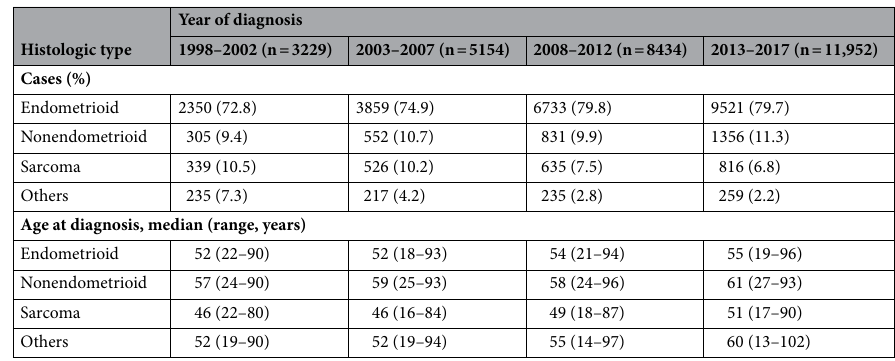
Table 1. Distribution of histologic types and age at diagnosis for 28,769 women with uterine corpus cancer from 1998 to 2017 in Taiwan.